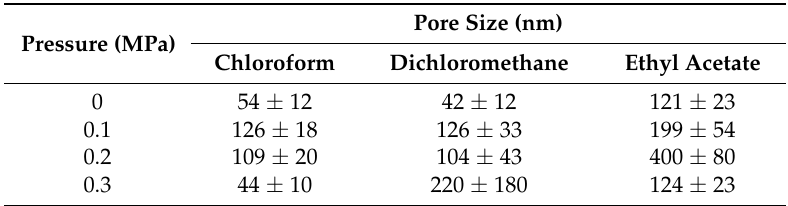
Table 3. Measured pore size of the fabricated